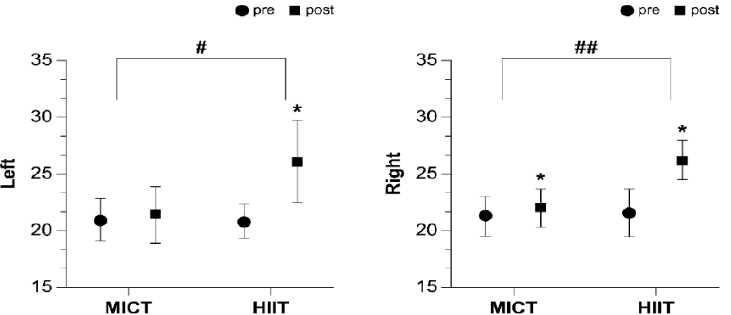
Figure 3. Effect on muscle strength according to exercise intensity. MICT: moderate-intensity continuous training, HIIT: high-intensity interval training. Bars represent mean ± SD (MICT: n = 8, HIIT: n = 8). * p < 0.05 from Pre to Post. # p < 0.05 change (post-pre) between groups. ## p < 0.01 change (post-pre) between groups.